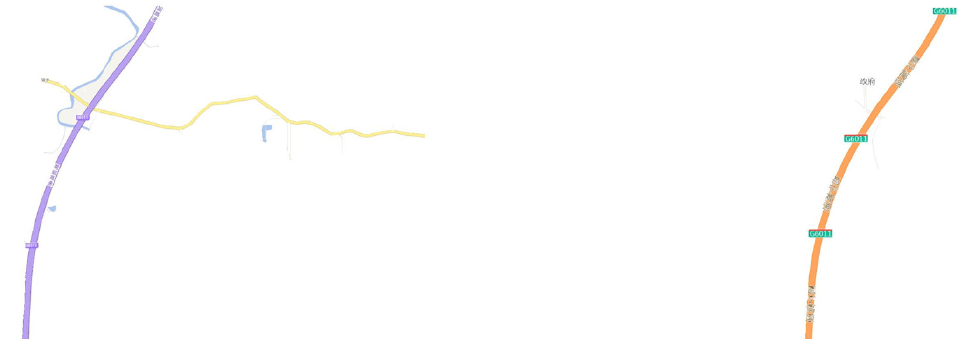
Figure 6. Results after feature surfaces matching fi ltering.